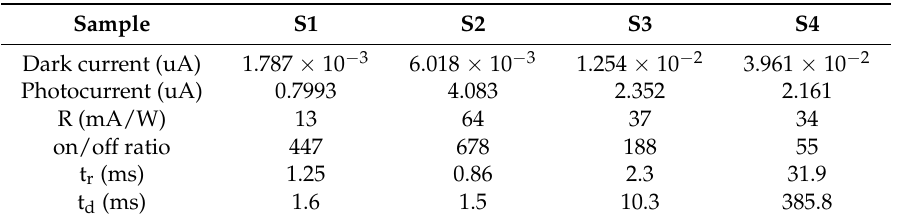
Table 2. The summarized parameters of the photodetectors fabricated with various perovskite thin films (sample S1–S4).